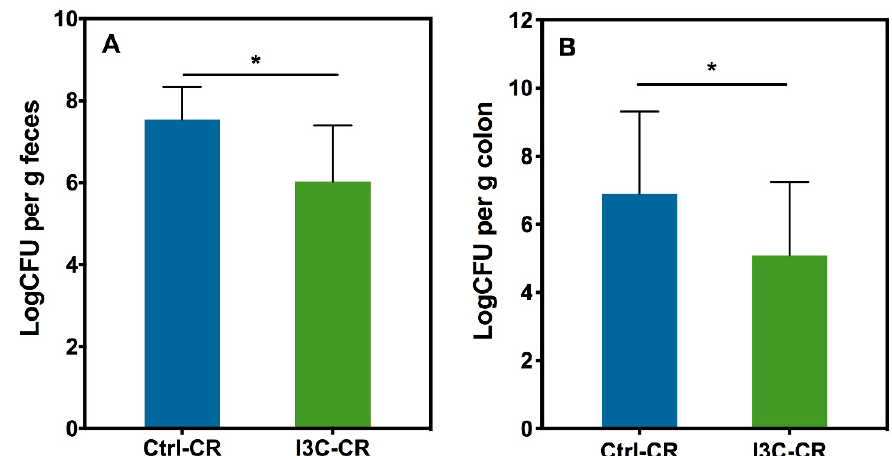
Figure 1. Effect of Indole-3-carbinol (I3C) on fecal and colonic Citrobacter rodentium ( Cr ) in mice. Mice were infected orally with approximately 1.0×10 10 CFU of C. rodentium . ( A ): Fecal excretion of Cr . The feces of mice were collected on day 11 after infection and the Log cfu/g feces determined set; ( B ): Colonic colonization of C. rodentium . Mice were sacrificed on day 12 post infection and the Log cfu/g colon tissue was determined. Results were expressed as mean +/- SD ( n = 8). * indicates significantly different from control ( p < 0.05).